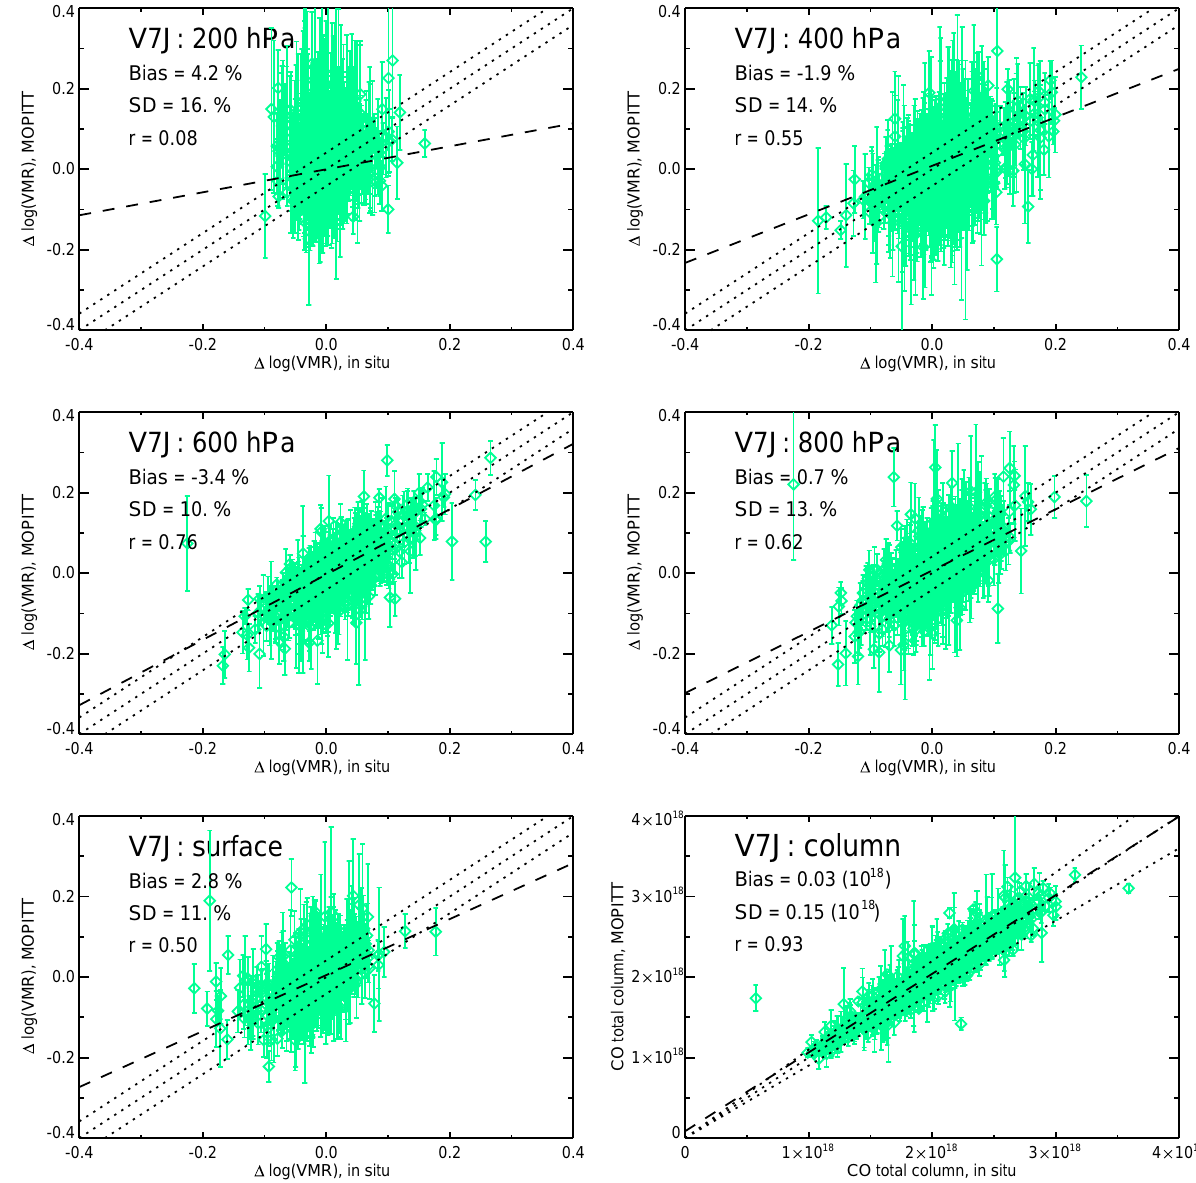
Figure 8. V7 TIR-NIR validation results based on the NOAA flask measurements. See caption to Fig.